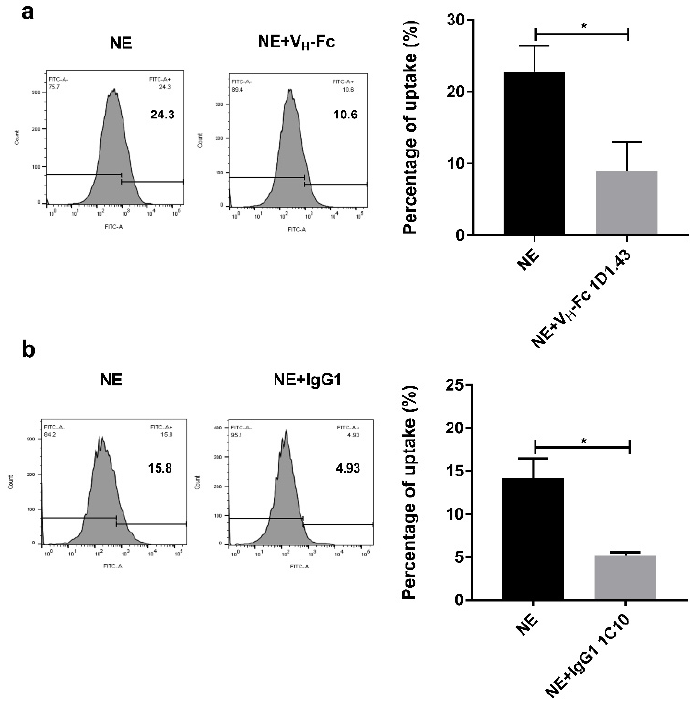
Figure 4. V H -Fc 1D1.43 and IgG1 1C10 inhibited NE uptaking by tumor cell. ( a , b ) Inhibition of VH-Fc 1D1.43 ( a ) and IgG1 1C10 ( b ) on NE uptaking by PC-3 tumor cell measured by flow cytometry. PC-3 cells were plated in a 24-well plate and incubated with serum-free medium for 24 h, then treated with 30 nM NE-FITC with or without 100 nM antibody proteins for 1 h. Experiments were performed in duplicate; unpaired Student’s t -test, * p < 0.05. Values were reported as the mean ± SD. Figure 5. V H -Fc 1D1.43 and IgG1 1C10 inhibited NE-promoted fibroblast differentiation. ( a ) Repre- sentative pictures of wound-healing assay. LL47 fibroblasts were plated into a 24-well plate and